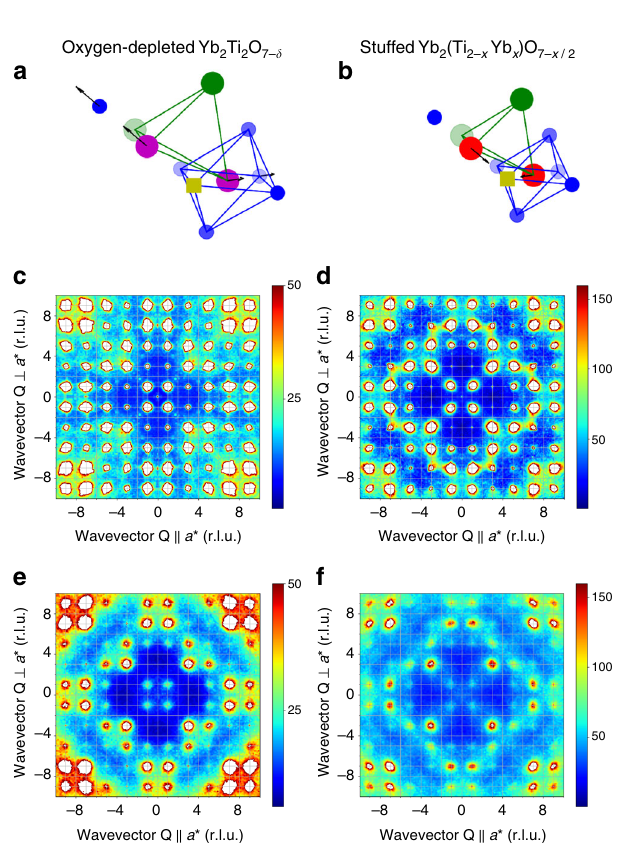
Fig. 1 The structure of defects in Yb 2 Ti 2 O 7 . a For oxygen-depleted Yb 2 Ti 2 O 7 − δ the oxygen vacancies (gold) are located on the O(2) sites (blue), and neighbouring Ti 4 + (green) are replaced by charge compensating Ti 3 + (purple) ions that are slightly displaced away from the vacancy. b For